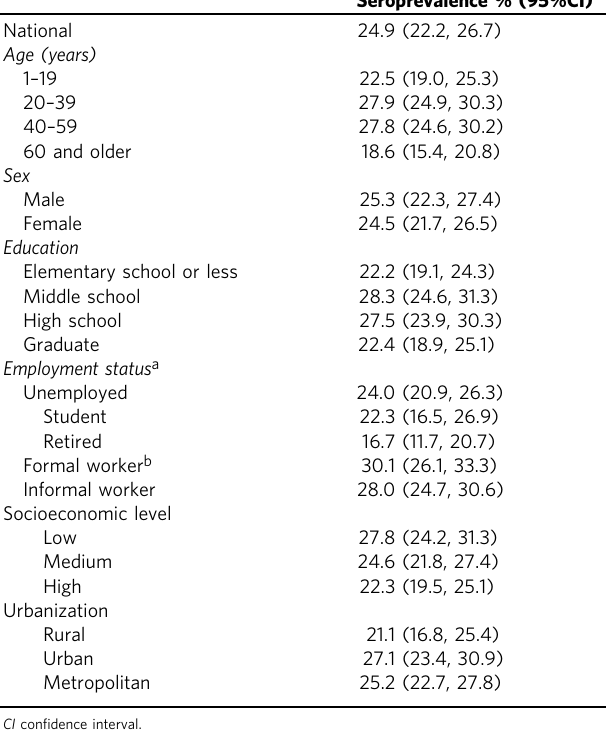
Table 1 Seroprevalence of antibodies anti-SARS-CoV-2 by sociodemographic characteristics. Mexico